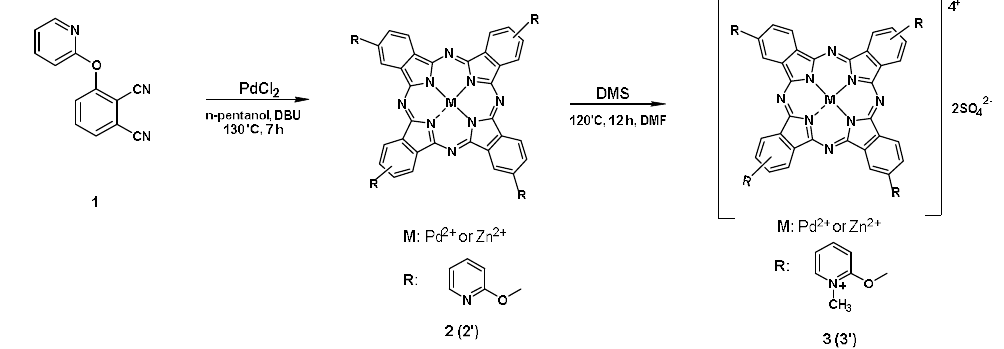
Figure 1. Synthesis of tetra-methylpyridiloxy-substituted Pd(II)- and Zn(II)-phthalocya- nines.